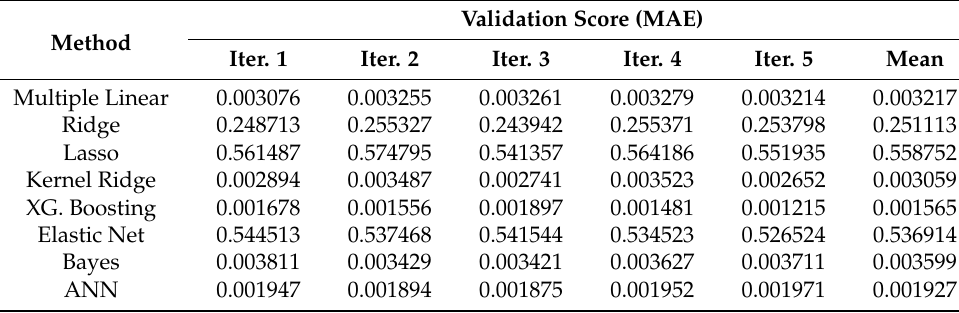
Table 4. K-Fold Cross-Validation scores for fuel consumption